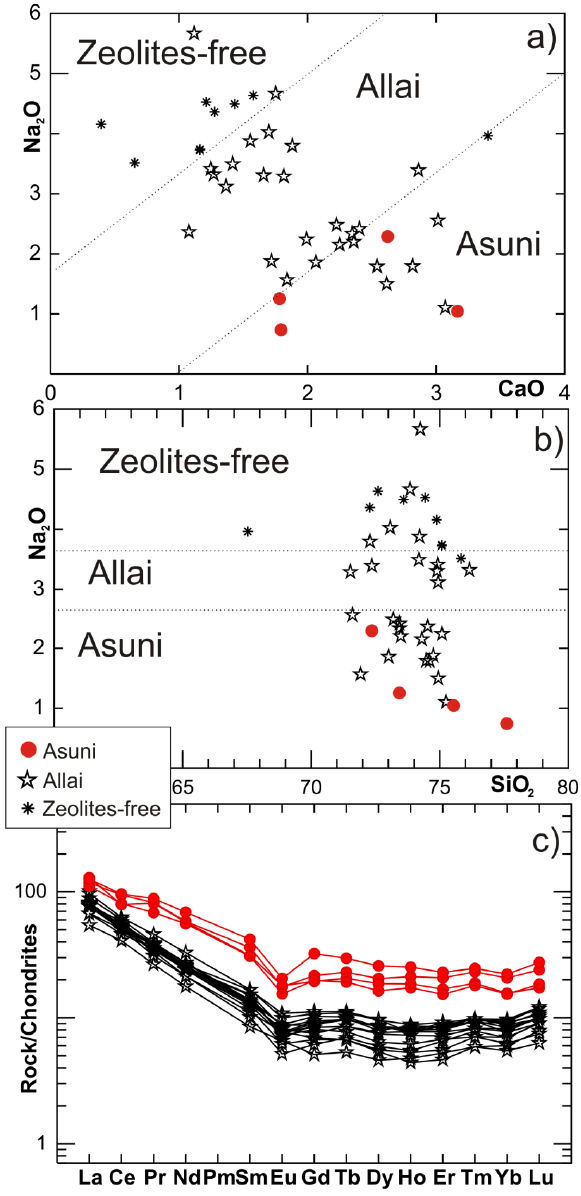
Figure 9. Plots showing the geochemistry of Asuni and Allai bulk-rocks and the related evolutionary trends: ( a ) CaO vs Na 2 O and ( b ) SiO 2 vs Na 2 O; the dashed line confines the Asuni and Allai zeolitized from zeolites-free rocks; ( c ) REE patterns of Asuni and Allai samples normalized to chondrites. Data from Table 2 and [30,62]. Chondrite values from [64]. However, Allai deposits tend to be rich in LREE relative to HREE, contrary to the Asuni rocks that show nearly flat patterns. In our opinion, the REE patterns and the alteration type provide evidence for the limited involvement of primary fluids in the Asuni tuffites which instead was dominant in the Allai pyroclasts. This is in agreement with the lithology of the deposits.